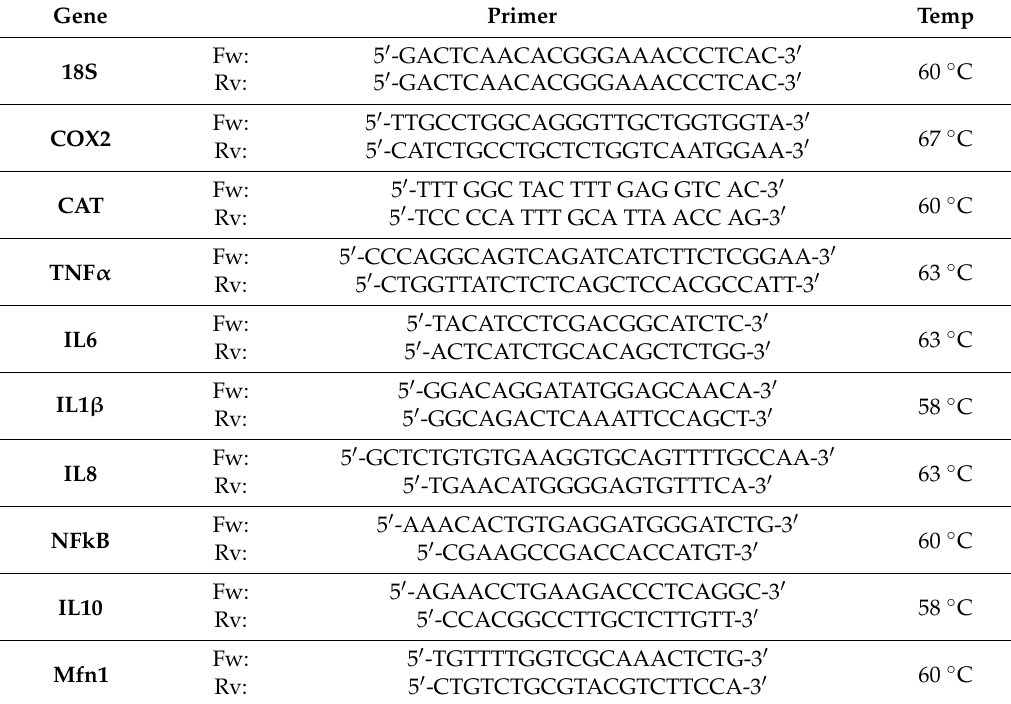
Table 1. Primer sequence and annealing temperatures used for the real-time